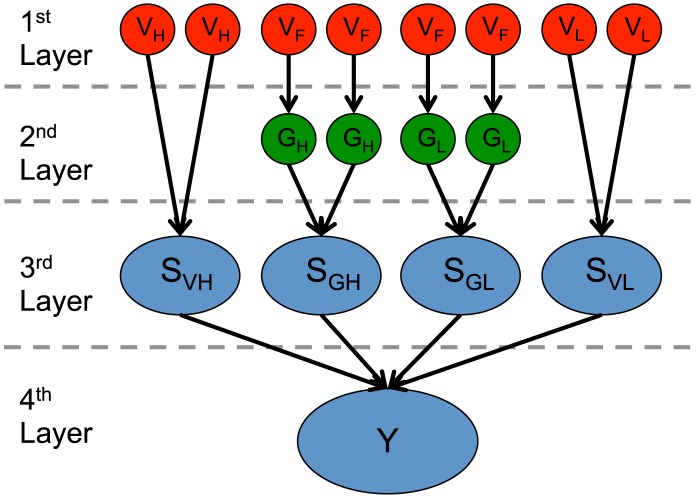
Topology of the model to predict phenotype from an individual's genome sequence.Red nodes in the first layer of the model represent the individual's genotype calls at genomic positions associated with the phenotype of interest. They are sorted into three categories: VH (HGMD DM variants), VL (NHGRI GWAS hits), and VF (<0.01 MAF in any population reported in ESP6500 (http://evs.gs.washington.edu/EVS/) or 1000 Genomes [30]), found in genes annotated as associated with the phenotype. Green nodes in the second layer represent genes split into high penetrance GH or low penetrance GL based on database annotations. Blue nodes in the third layer are Bernoulli random variables, abstractly representing mechanisms that explain the phenotype, sorted into those altered by high penetrance variants SVH, low penetrance variants SVL, high penetrance genes SGH, or low penetrance genes SGL. The blue node Y is a Bernoulli random variable representing individual phenotypic status. Directed edges show the dependencies between nodes. A set of model parameters is estimated for each phenotype and each individual.